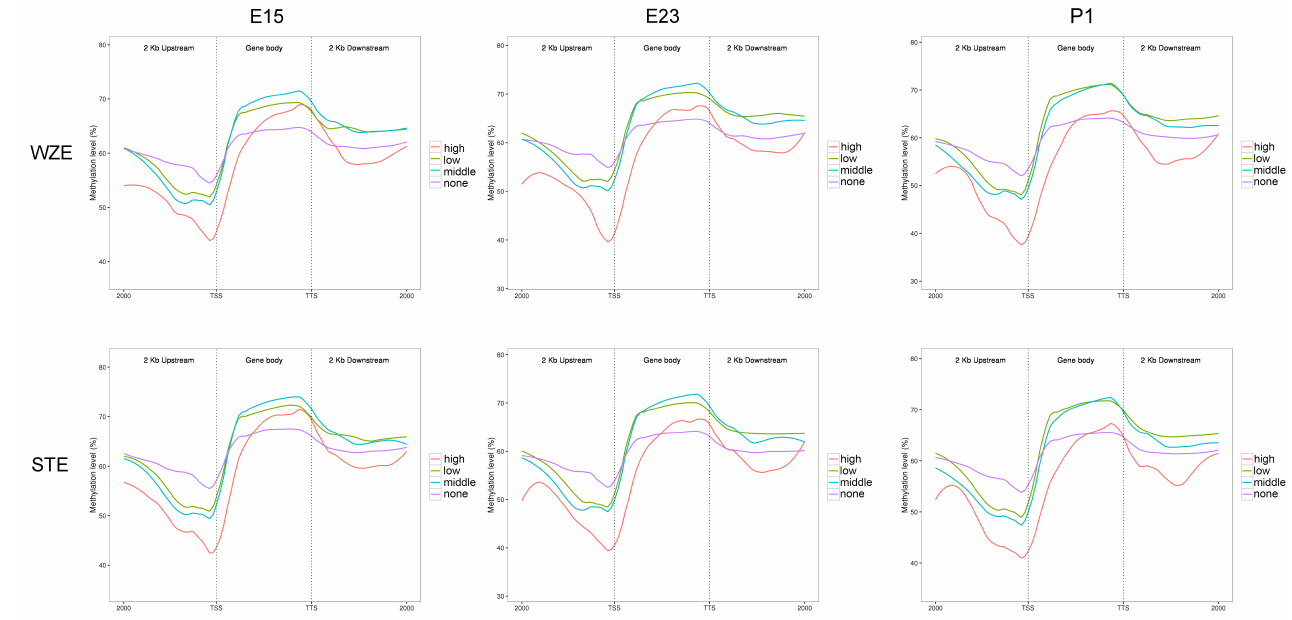
Figure 3. WGBS-transcriptomic data integration in gene regulatory regions between two goose breeds. According to RNA-seq data, genes were considered as differentially expressed (DEGs) if |log2(FC)| ≥ 1 and FDR ≤ 0.05. FPKM ≥ 100 was regarded as high expression; 10 ≤ FPKM < 100 was regarded as middle expression; 0 ≤ FPKM < 10 was regarded as low expression; FPKM = 0 was regarded as no expression. CG methylation levels in gene regulatory regions (upstream 2 kb, gene body, and downstream 2 kb) were analyzed in each